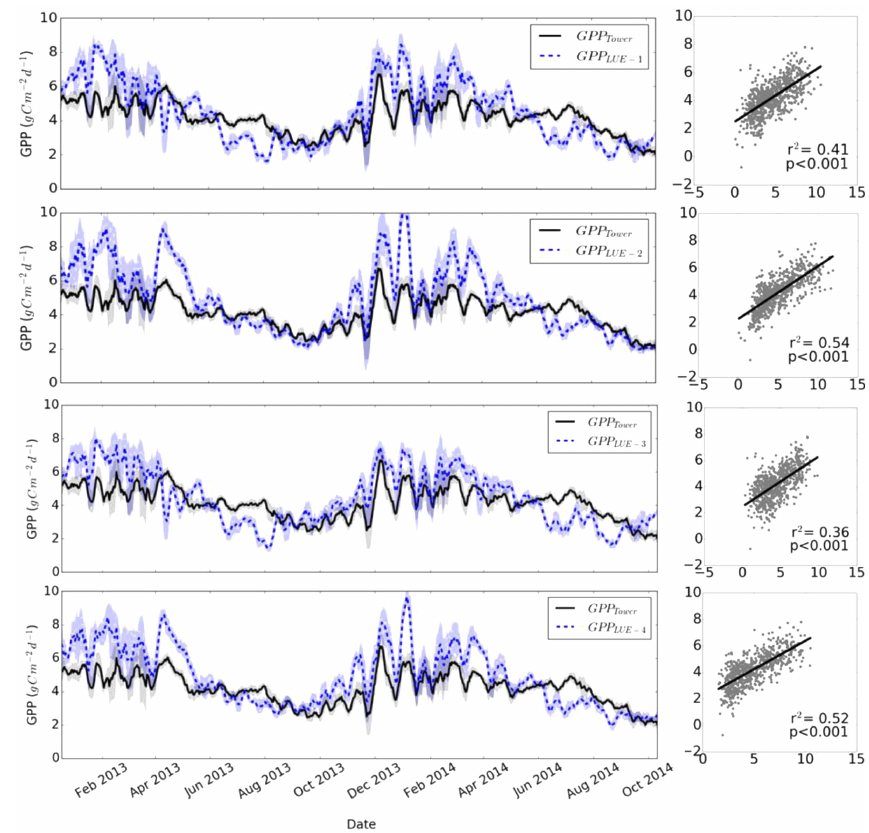
Figure 8. Overstory flux tower estimated GPP with model predicted GPP for the Howard Springs OzFlux site. Models shown are (a) light use efficiency (LUE-1), (b) LUE with evaporative fraction (LUE-2), (c) LUE with green chromatic coordinates (LUE-3) and (d) LUE with EF and GCC